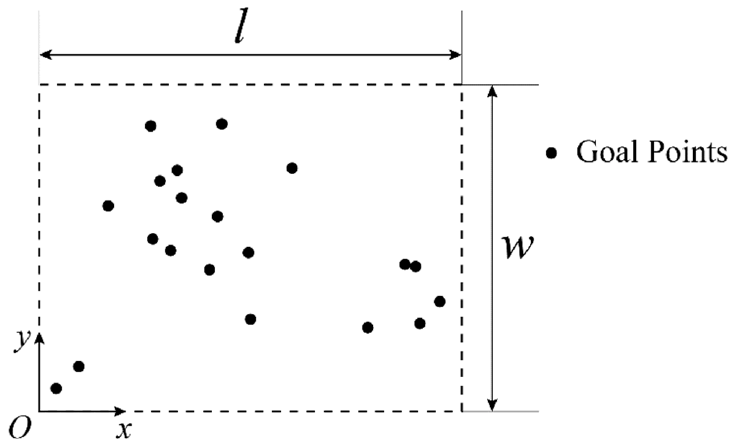
Figure 1. Workspace of the multiple-target path planning problem.